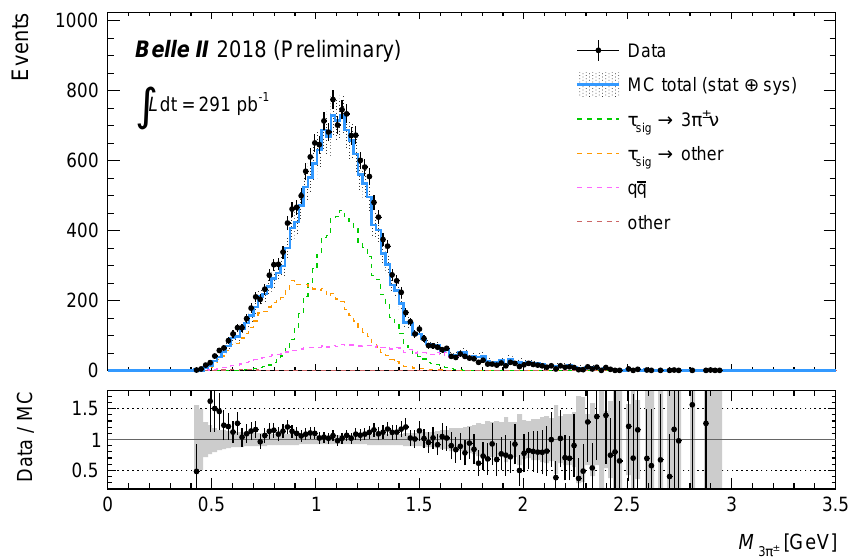
Figure 2: Invariant mass distribution of the three pions coming from τ → 3 πν can- didates reconstructed in Phase II data. Events in data are required to fire the CDC trigger. MC is rescaled to a luminosity of 291 pb − 1 and reweighted according to the trigger efficiency measured in data. The error band on the total MC includes the MC statistical uncertainty, the luminosity uncertainty, and the uncertainty associated with the trigger efficiency